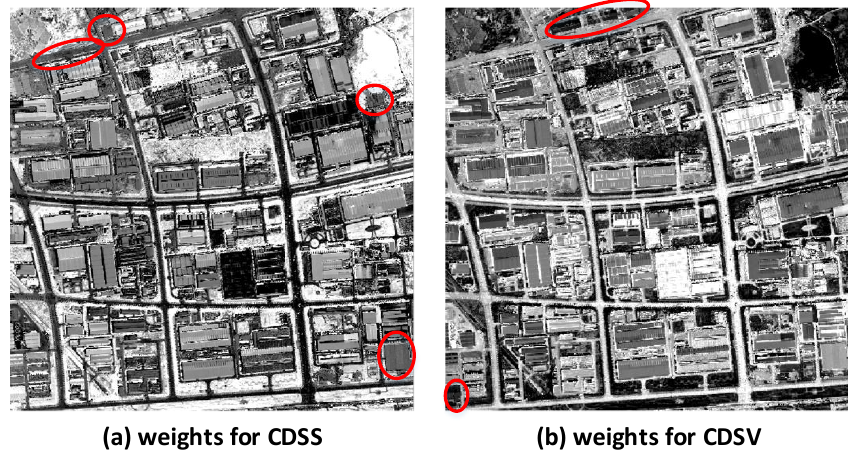
Figure 11. The weights image of CDSS and CDSV.